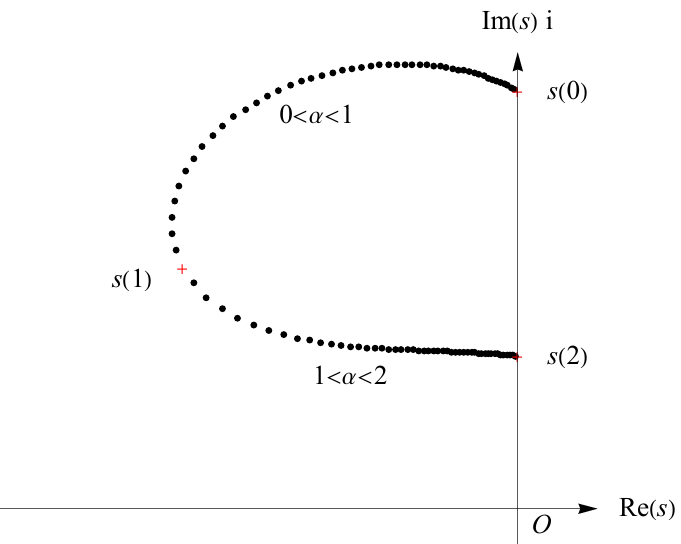
Figure 9. Trajectory of roots s ( α ) for α varying between 0 and 2, where b = 4 and c = 8 ( b 2 − 4 c < − b ) . From the trajectories of roots, s ( α ) has a faster change rate as α approaches 1. For the cases of b 2 − 4 c ≥ 0, the imaginary part of the root s ( α ) can become arbitrarily small as α approaches 1. For the case of b 2 − 4 c < 0, the smaller the value b 2 − 4 c , the larger the imaginary part of the root s ( 1 )